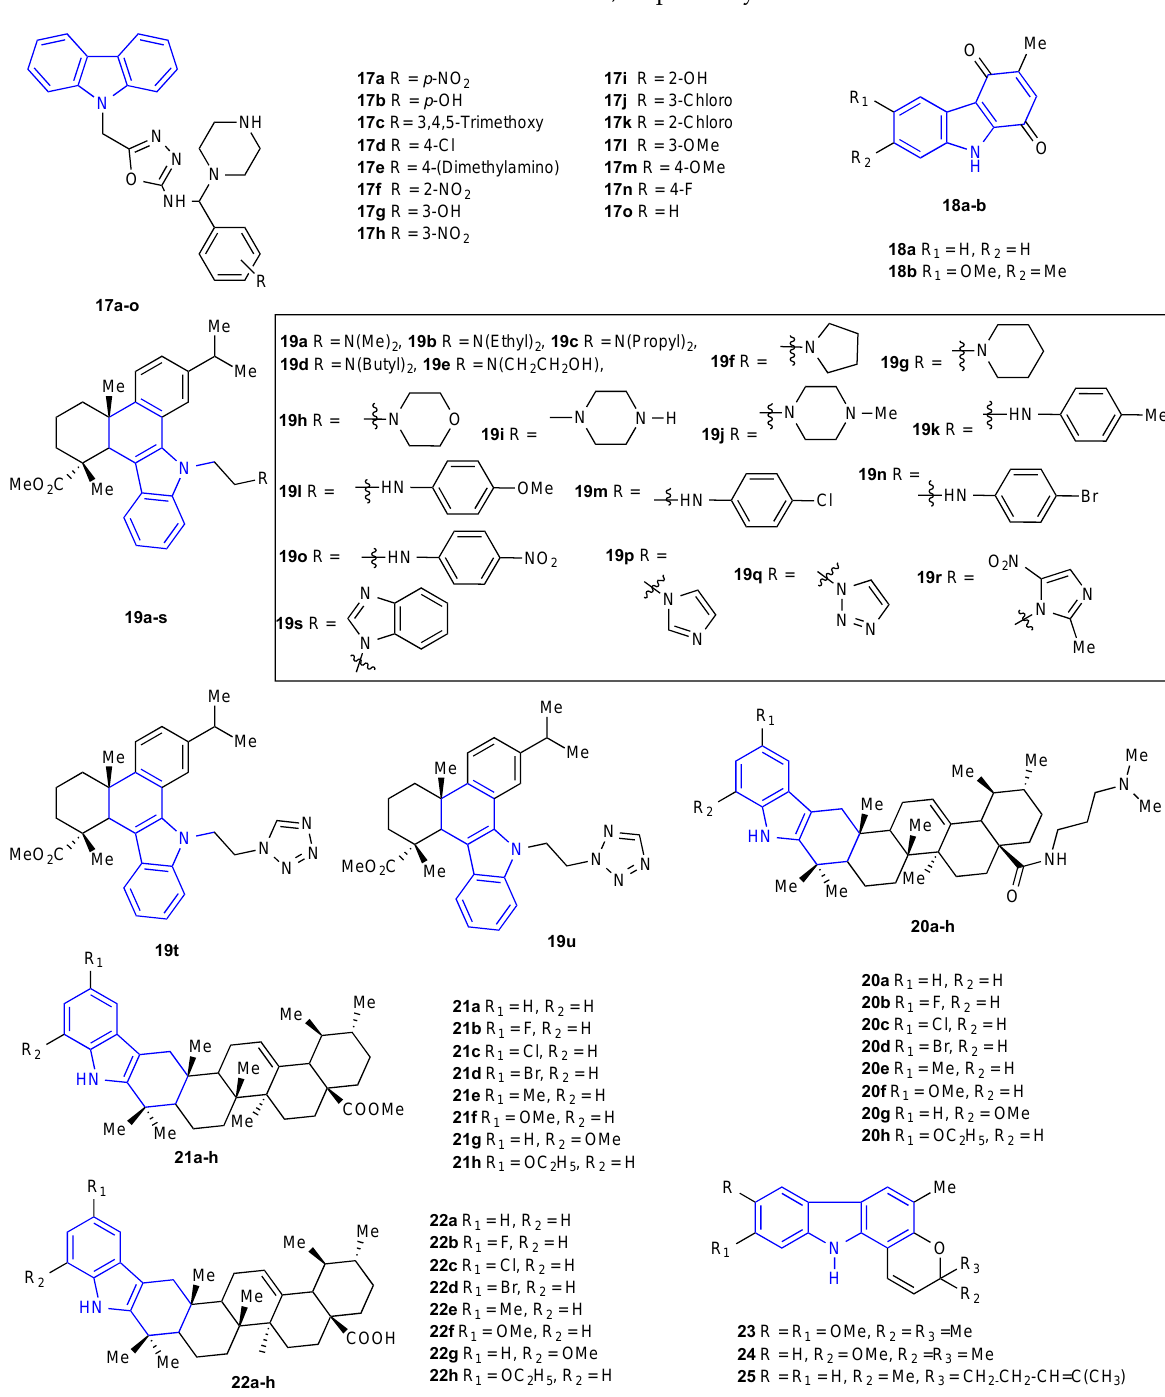
showed the strongest inhibition towards C. albicans and S. aureus with zones of inhibition of 14.5 ± 0.1 and 13.8 ± 0.1 mm, respectively.